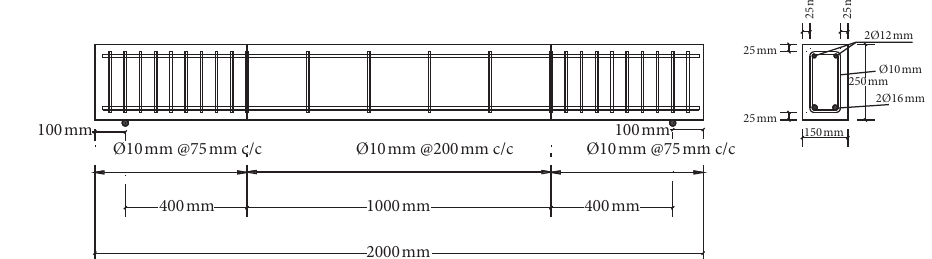
Figure 1: Dimensions and reinforcement details of the test